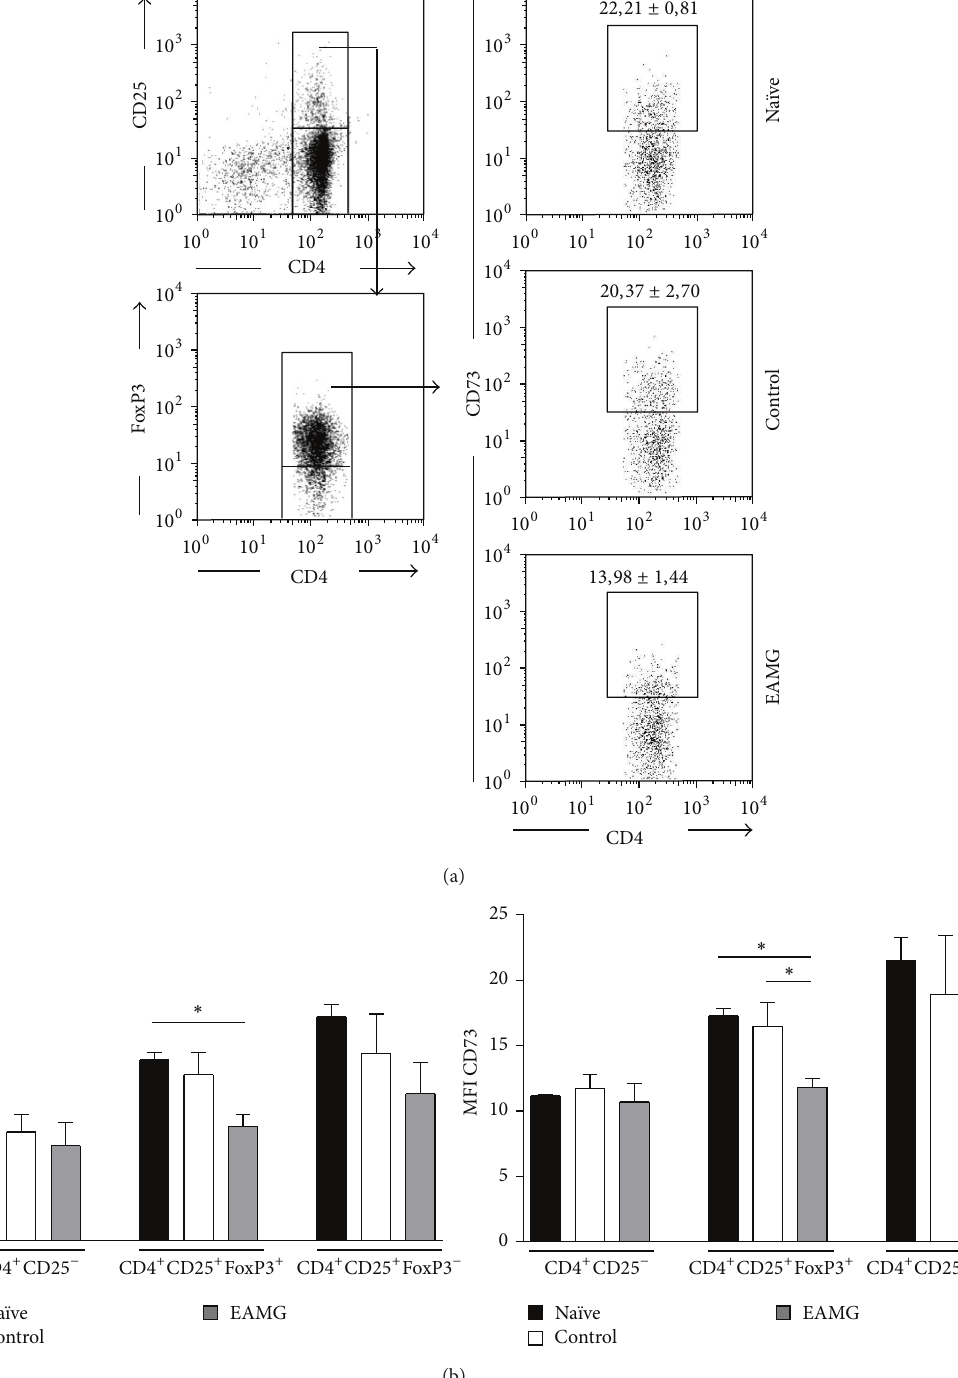
Figure 2: (a) Flow cytometry analysis of surface CD73 expression on CD 4 + CD 25 + FoxP 3 + T cells of popliteal and inguinal lymph nodes from na¨ıve, control, and EAMG animals. Gating strategies are indicated on dot plots on the left. Dot plots on the right show CD73 expression within CD 4 + CD 25 + FoxP 3 + T cells and are a representative example of each indicated group. Numbers inside dot plots correspond to mean percentage ± SEM of CD 73 + cells. (b) Percentage of CD 73 + cells (left) and mean fluorescence intensity (MFI) due to CD73 (right) staining within the indicated cell populations. Bars represent means ± SEM of 5 experiments for each animal group. ∗ 𝑃 < 0.05 , ∗∗ 𝑃 < 0.01 (one-way ANOVA and Bonferroni’s post hoc test) compared to na¨ıve and control animals,